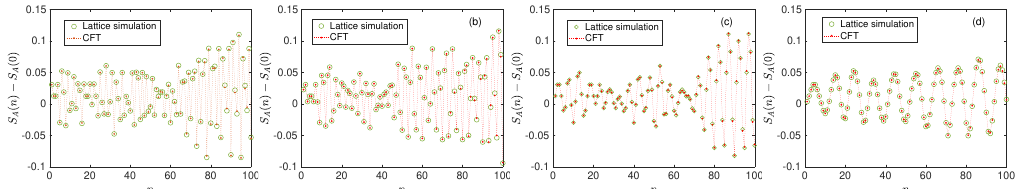
Figure 18: Comparison of lattice simulations and CFT results for the entangle- ment entropy evolution in the heating phase with a single random sequence. Here we choose the same random sequence as Fig. 17. We take L = 1600 and / L − 1 / 2 = T ( θ ) / L ( θ ) − 1 / 2 which equals (a) 0.1, (b) 0.2, (c) 0.3, and T 0 eff